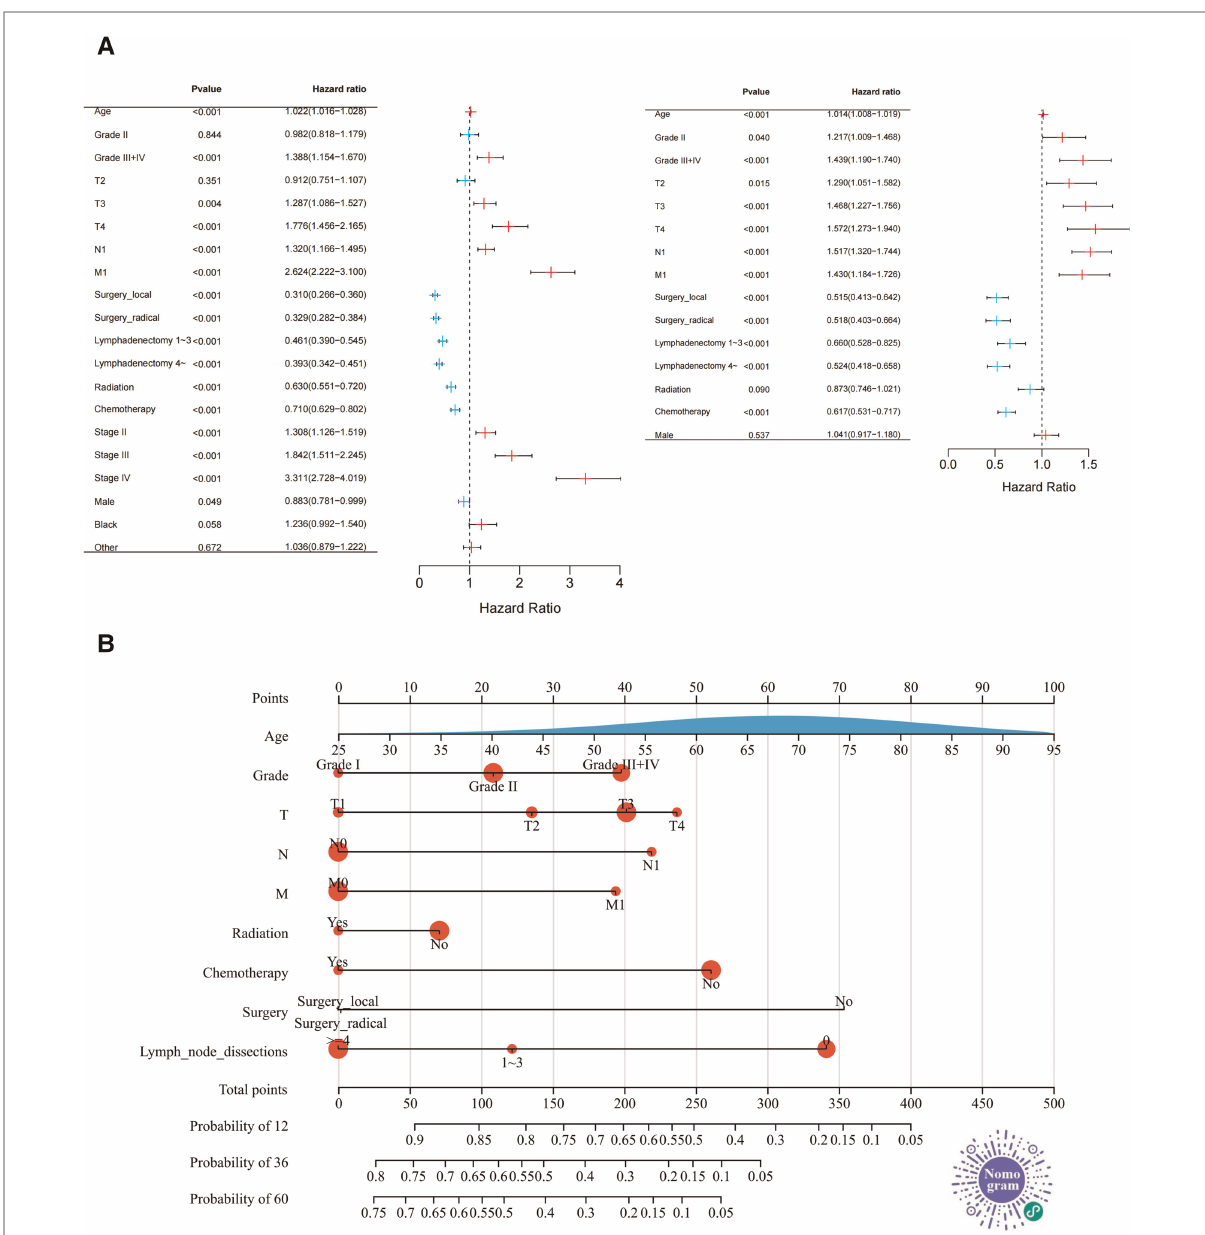
FIGURE 3 Forest plot and nomogram for training set. ( A ) The Forest Plot shows the results of Cox proportional Hazard regression analysis (Left: univariate analysis; right: multivariate analysis. ( B ) The novel nomogram was constructed based on Independent prognostic factors for predicting 1-, 3-, or 5-year survival rates in pCCA. As shown above, the 9 variables correspond to the upper level subscales, and the total score of each variable down corresponds to the 1, 3, and 5 year overall survival associated with the prediction. The area of the red dots represents the number of samples and the distribution of age (a continuous variable) is presented as the area under the blue curve. Two-dimensional code that makes the nomogram accessible in